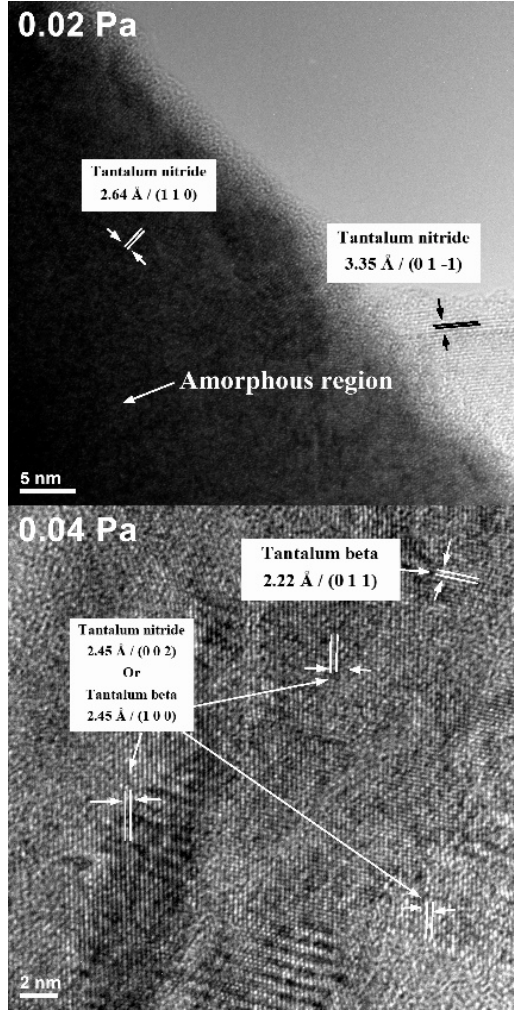
Figure 8. HRTEM images of the samples produced with P (N 2 + O 2 ) = 0.02 Pa and P (N 2 + O 2 ) = 0.04 Pa.